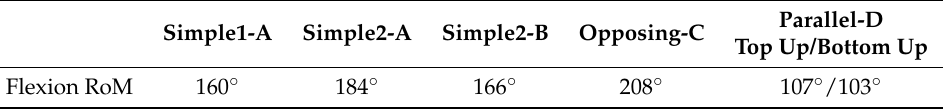
Table 1. Maximum actuator tip angles for flexion trajectory